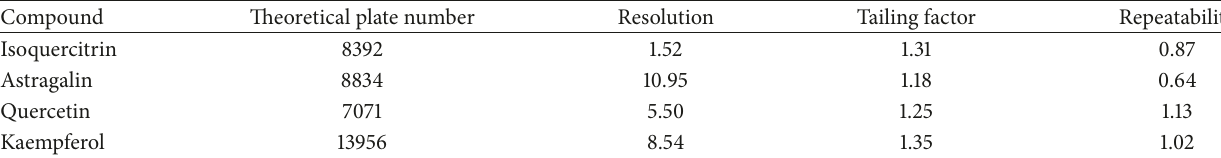
Table 1: System suitability test (SST) of HPLC.